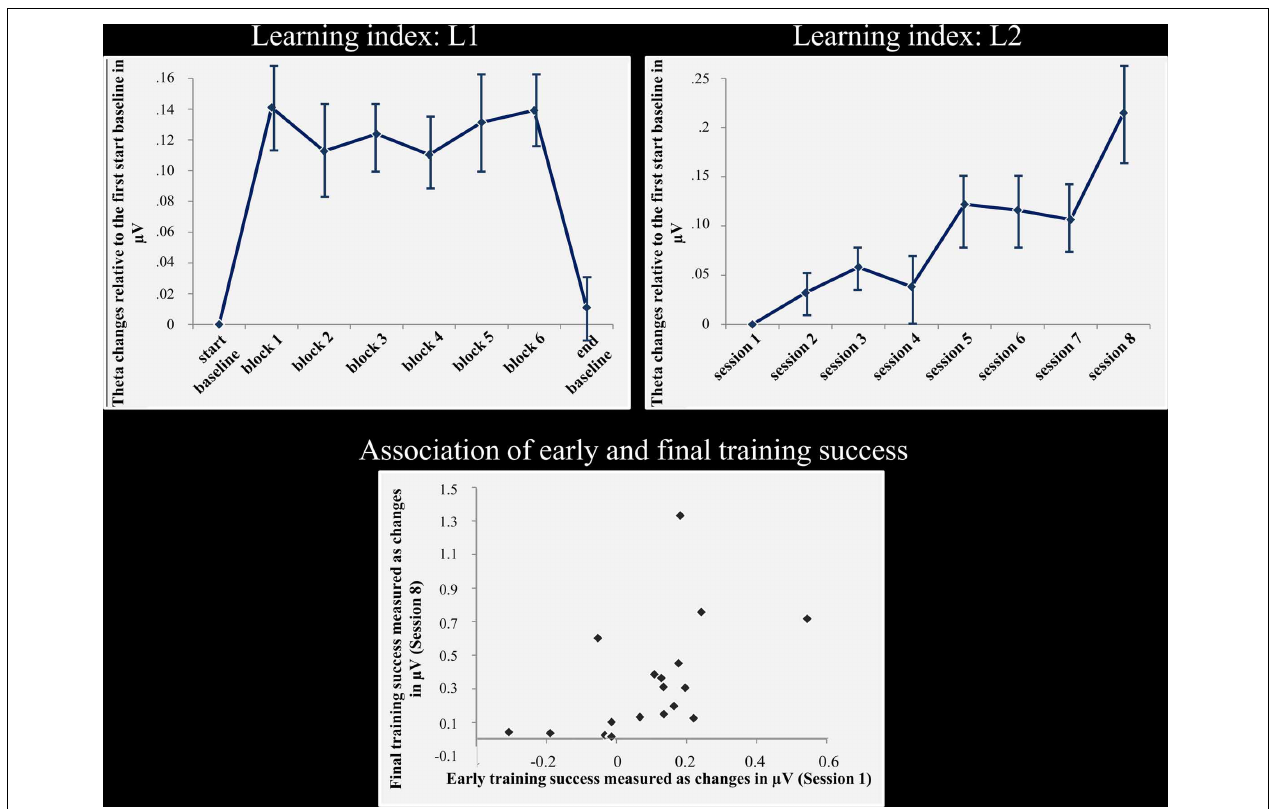
FIGURE 1 | Neurofeedback success and association of early and final training success. Top: the left column shows the fm-theta increase as reflected by the learning L1. This index reflects amplitude changes calculated across all training sessions for the start baseline measurement, blocks 1–6, and the end baseline measurement. During feedback, fm-theta is strongly enhanced compared to the start and end baselines. The right column depicts the fm-theta changes during the course of training, beginning with sessions